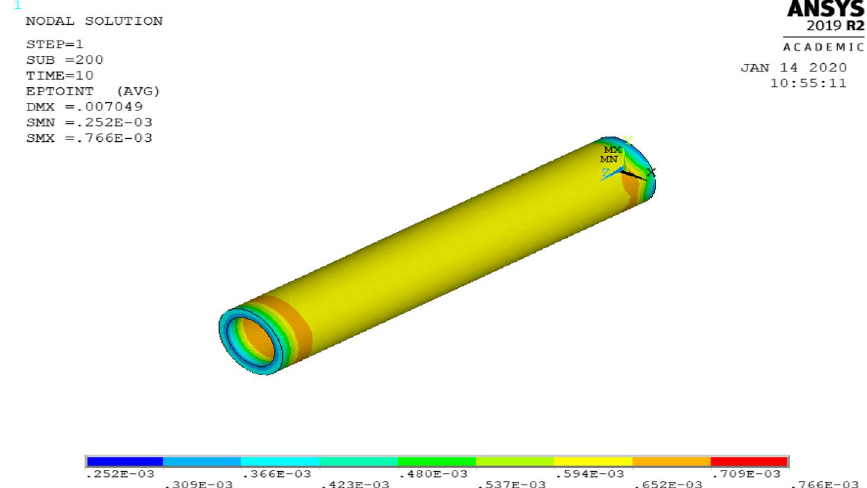
Fig. 18 Maximum strain at coupler edge from dynamic